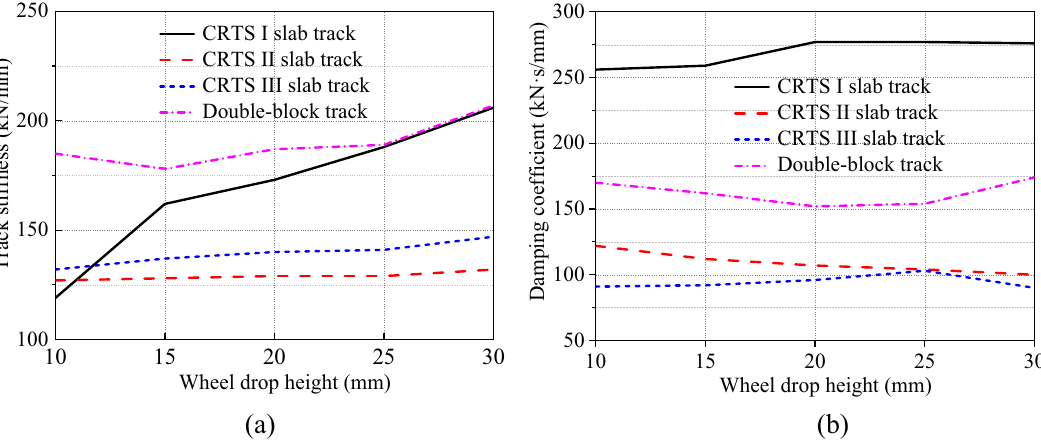
Fig. 18 Ballastless track dynamic stiffness and damping coefficient varying with the wheel-drop heights [26]: a dynamic stiffness; b damping coefficient